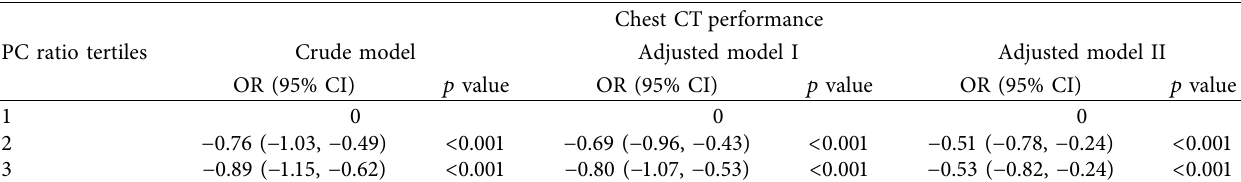
Table 2: Relationship between PC ratio and chest CT